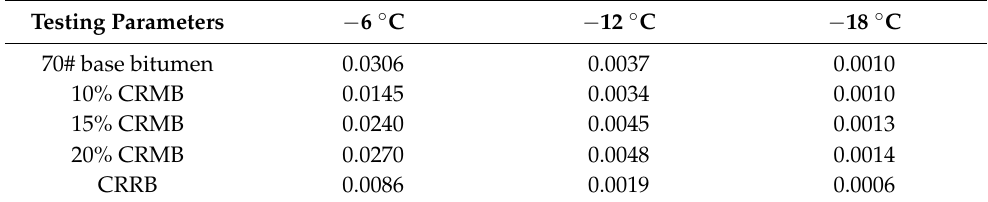
Figure 7. S value of bitumen. Table 3. k value of bitumen at different temperatures.